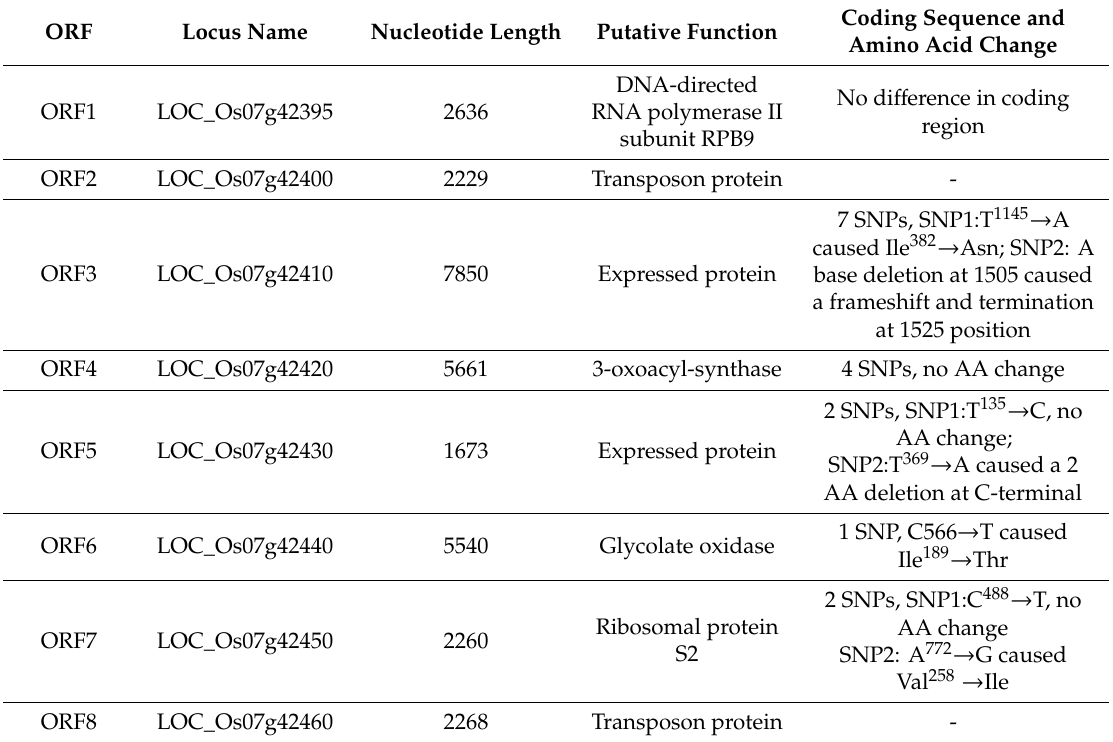
Table 2. Candidate genes for the qGS7 in the 52.8 kb